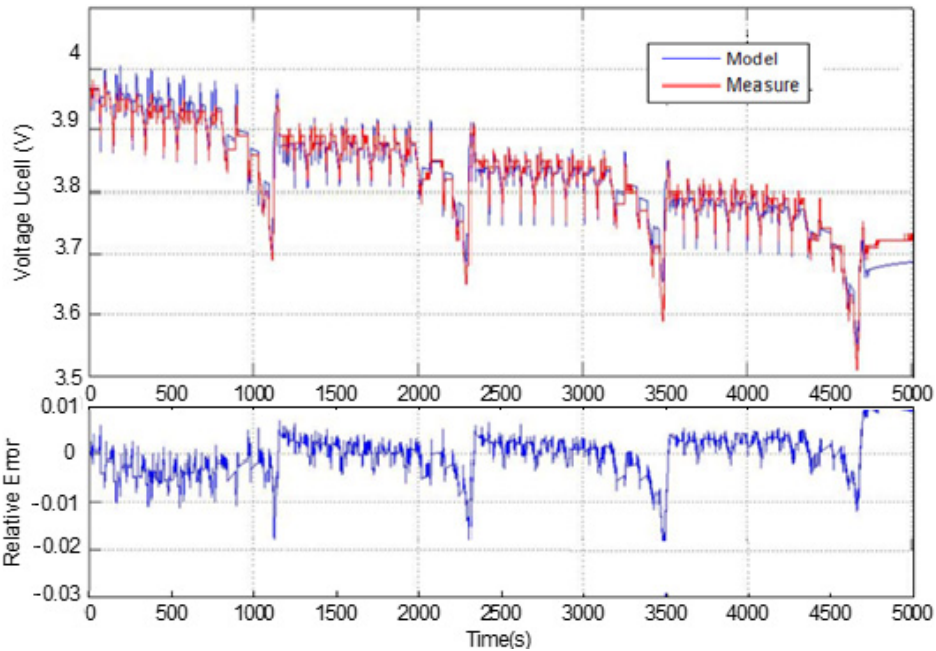
Figure 17. Verification test performed using 4 NEDC; comparison of the Thevenin model prediction with the experimental data and relative error is even at a lower level than in Figure 12.